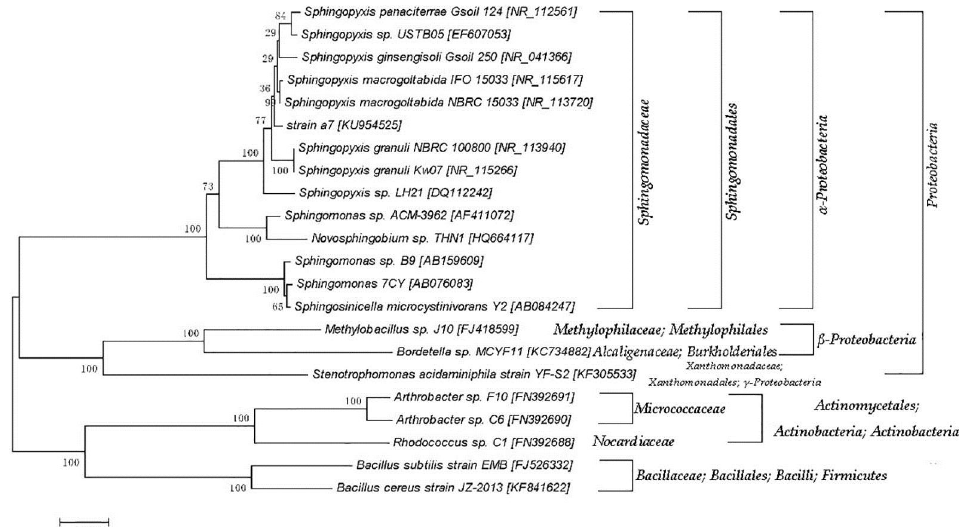
Figure 2. A phylogenetic tree based on the bacterial 16S rDNA sequence from the isolated strain a7 and the closely related species. The numbers at the nodes are the levels of bootstrap support (%) based on the neighbor-joining analyses of 1000 resampled datasets. The scale bar represents 0.02 nucleotide substitutions per position.